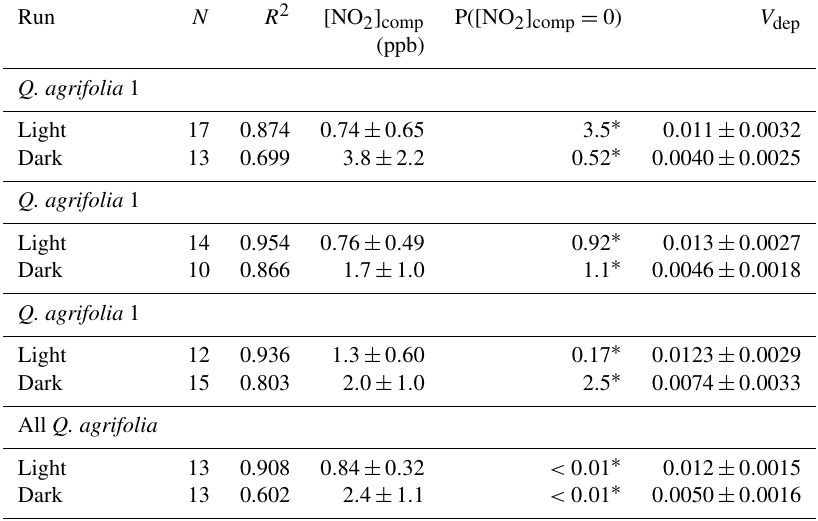
Table 2. Parameters of NO bivariate linear least-square fitting regression analysis.